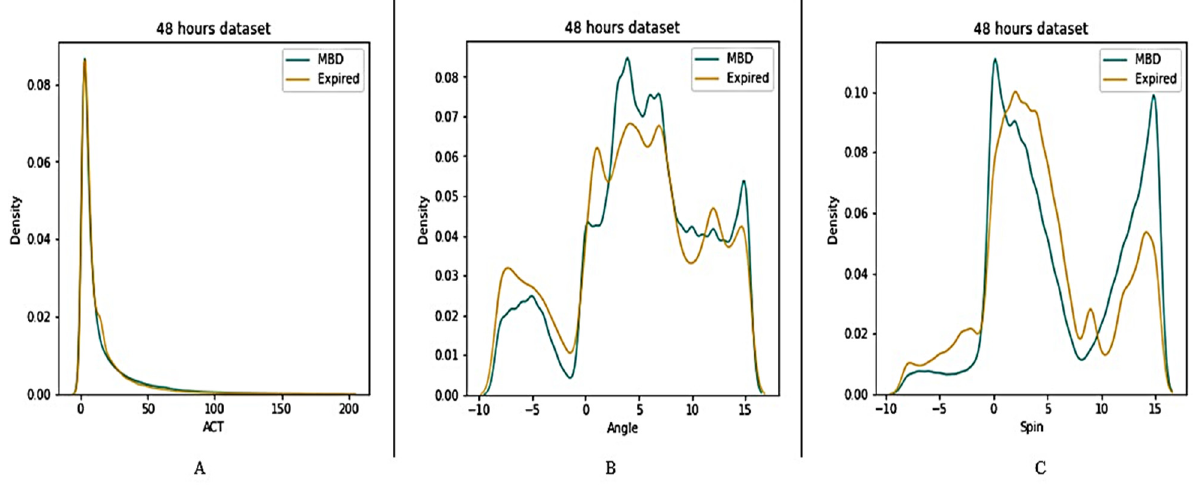
Figure 7. Description of wearable dataset at 48 h interval based on ( A ) ACT, ( B ) Angle ( C ) Spin.